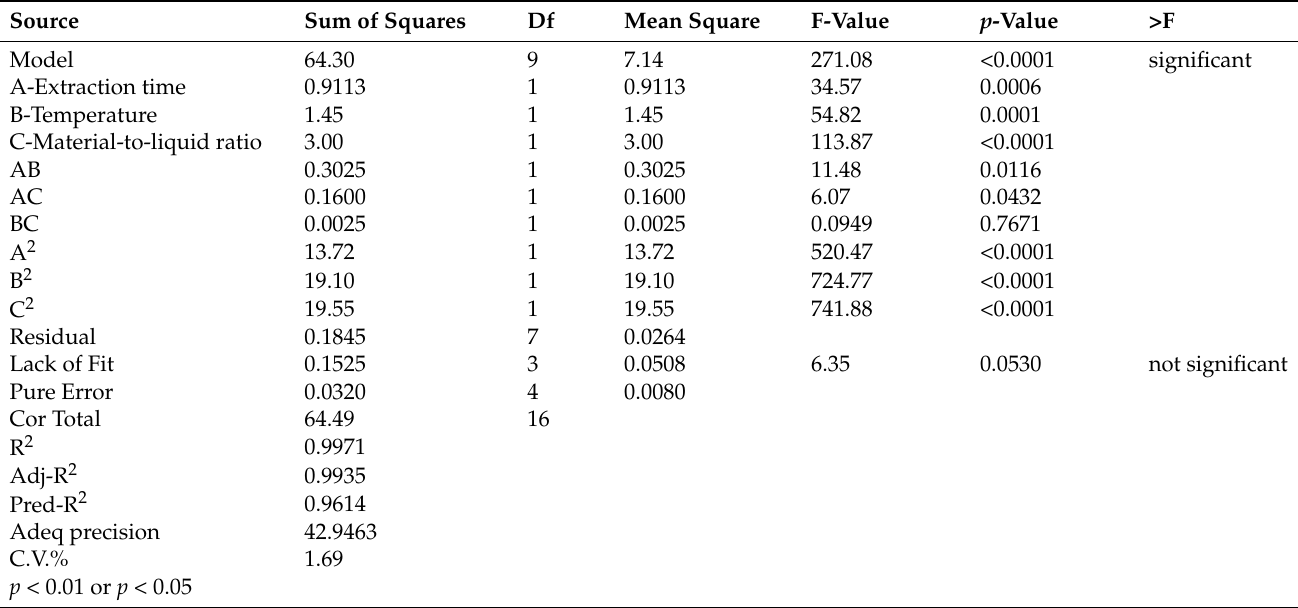
Table 3. Variance analysis of the Cers yield response surface quadratic